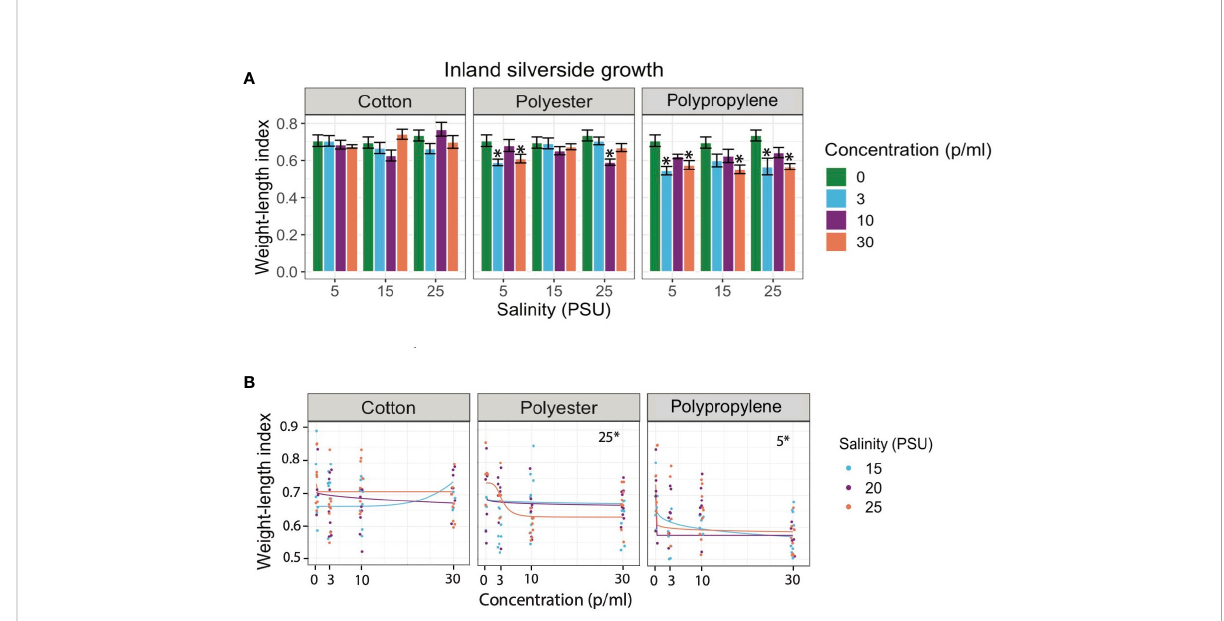
FIGURE 2 (A) Bar graphs of juvenile Silverside ( M. beryllina ) larvae growth exposed to cotton, polyester, and polypropylene micro fi bers across 0 - 30 p/ mL concentration and 15-25 PSU salinity gradient respectively. Asterisks represent statistically signi fi cant differences relative to the controls. Only effects relative to the control are shown ( a < 0.5; TukeyHSD). (B) Dose response curves (DRCs) of juvenile Silverside ( M. beryllina ) larvae growth exposed to cotton, polyester, and polypropylene micro fi bers across 0 - 30 p/mL concentration and 15-25 PSU salinity gradient respectively. Each circle in the DRCs represents the rescaled growth index mean of one larva (n=9) and regression lines are plotted from the DRC model from the R drc package. Data are presented on a log